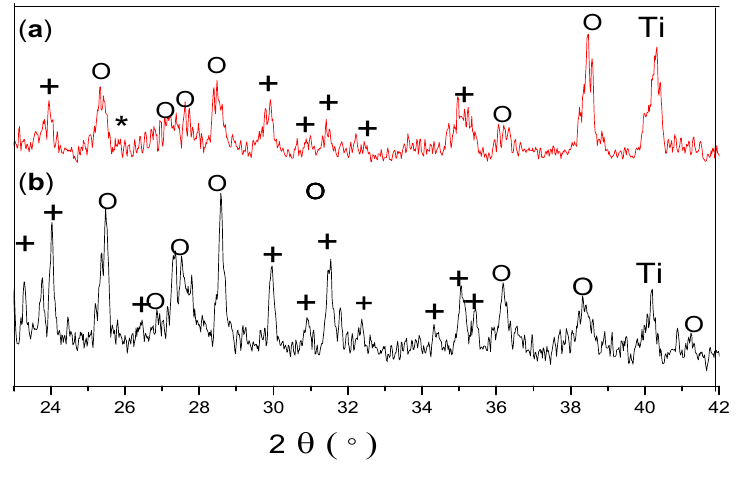
Figure 3. XRD spectra of the double layer coatings on Ti substrates after heat treatment at 550 °C for 30 min in air: (a) HA-CNT/TiO coating. ( O ): TiO ; ( + ): HA; (*): 2